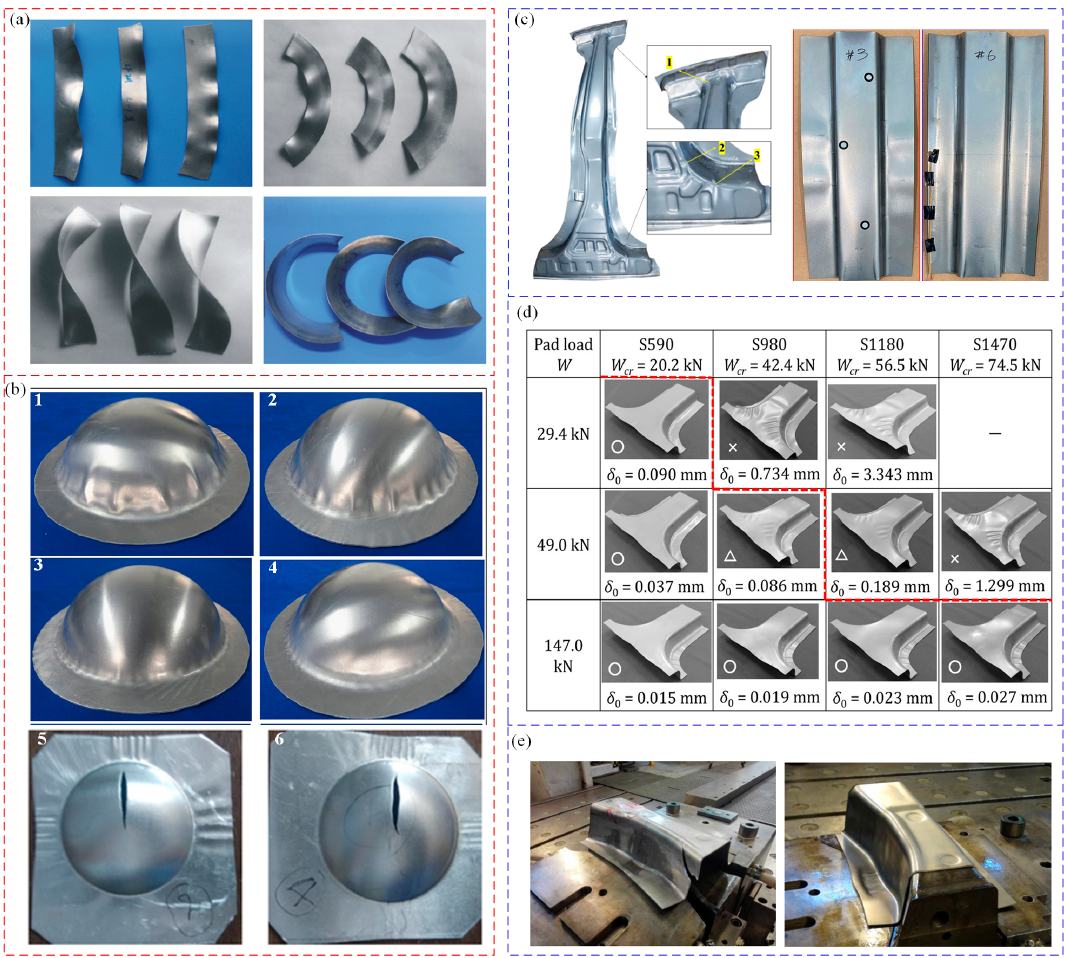
Figure 18. Engineering applications of avoiding deformation instability: ( a ) in-plane bending of plates [213]; ( b ) hydroforming of sheet metal [216,218]; ( c ) stamping of ultra-high strength steel [123,219]; ( d ) stamping of high tensile strength steel [220]; ( e ) stamping of AA2198 aluminum alloy